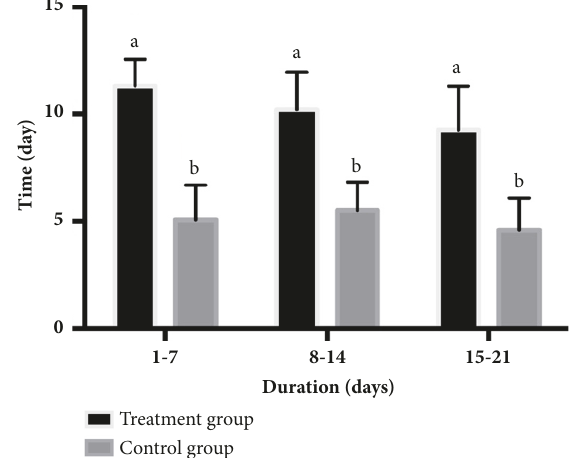
Figure 3: Cortisol level in fecal matter of sows in the treatment group (exposed to AS sounds) and the control group (not exposed to AS sounds) in each lactating period (1-7, 8-14, and 15-21 days after parturition). ∗ Statistical significance ( P < 0.05 ) within groups.